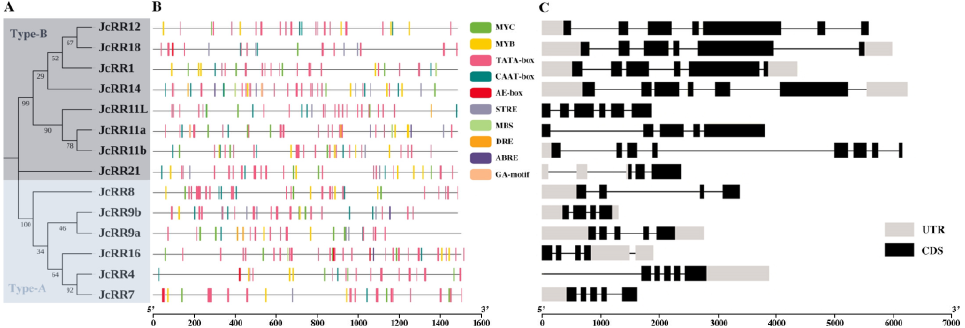
Figure 3. Evolutionary analysis and genomic organization of JcRRs . ( A ) Phylogenetic tree of type-A and type-B JcRRs . ( B ) Analysis of cis -acting elements in the promoter region (1500 base pairs (bp) upstream of the start codon); each motif is represented by a specific color. ( C ) Genomic organization of JcRRs . Untranslated regions (UTRs) and coding DNA sequence (CDS) regions are represented by solid gray and black boxes, respectively.